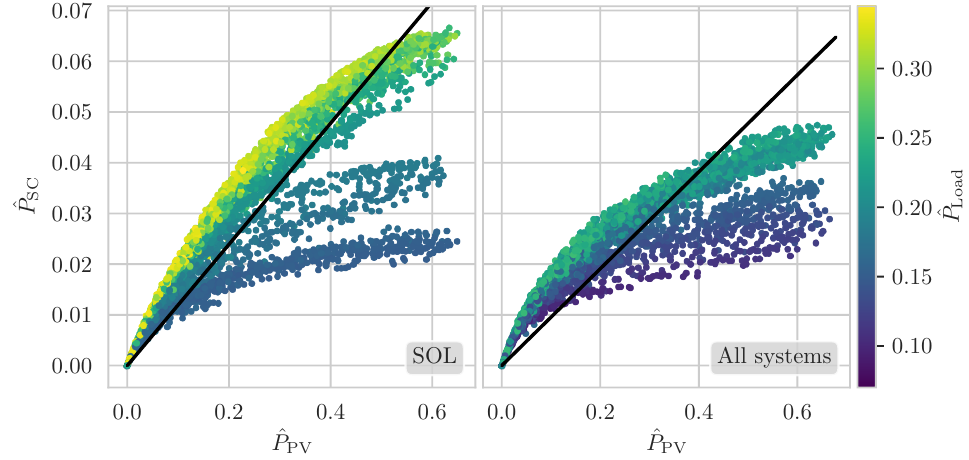
Figure 7. Dependency of self-consumption on PV generation and load for the SOL ( left ) and the complete model ( right ) portfolios. The scatter symbols show the specific self-consumption ˆ P SC and PV generation ˆ P PV for each time step coloured by the corresponding specific load ˆ P Load . The black lines indicate the relation between self-consumption and PV generation as predicted by the linear “PV-scaled” reference model based on the modelled overall self-consumption